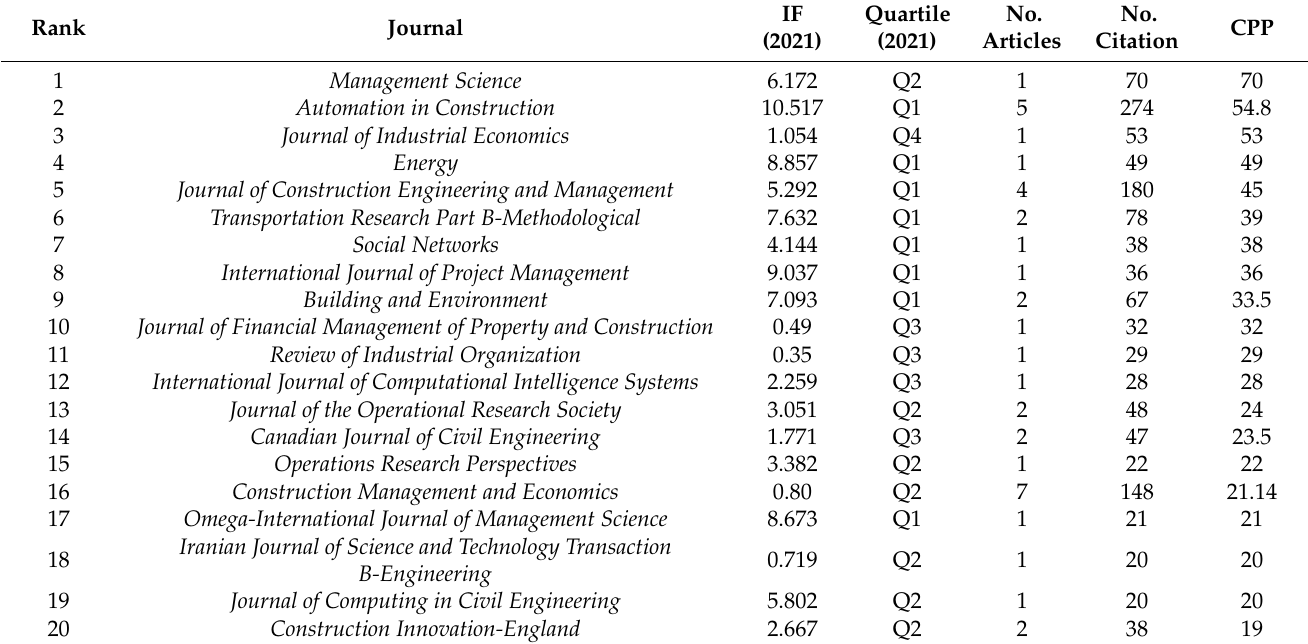
Table 1. Top 20 journals on construction bidding studies (ranked by